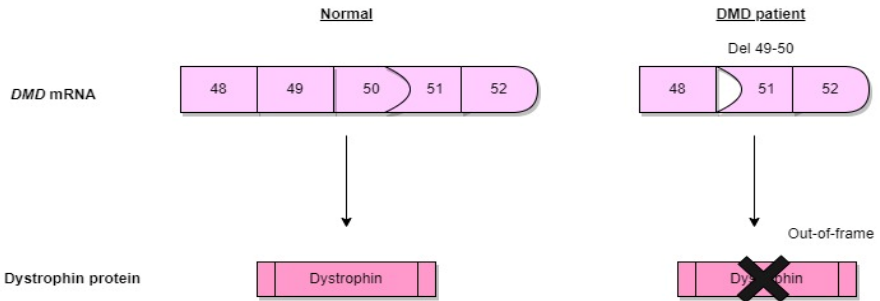
Figure 1. The schematic diagram of the dystrophin.